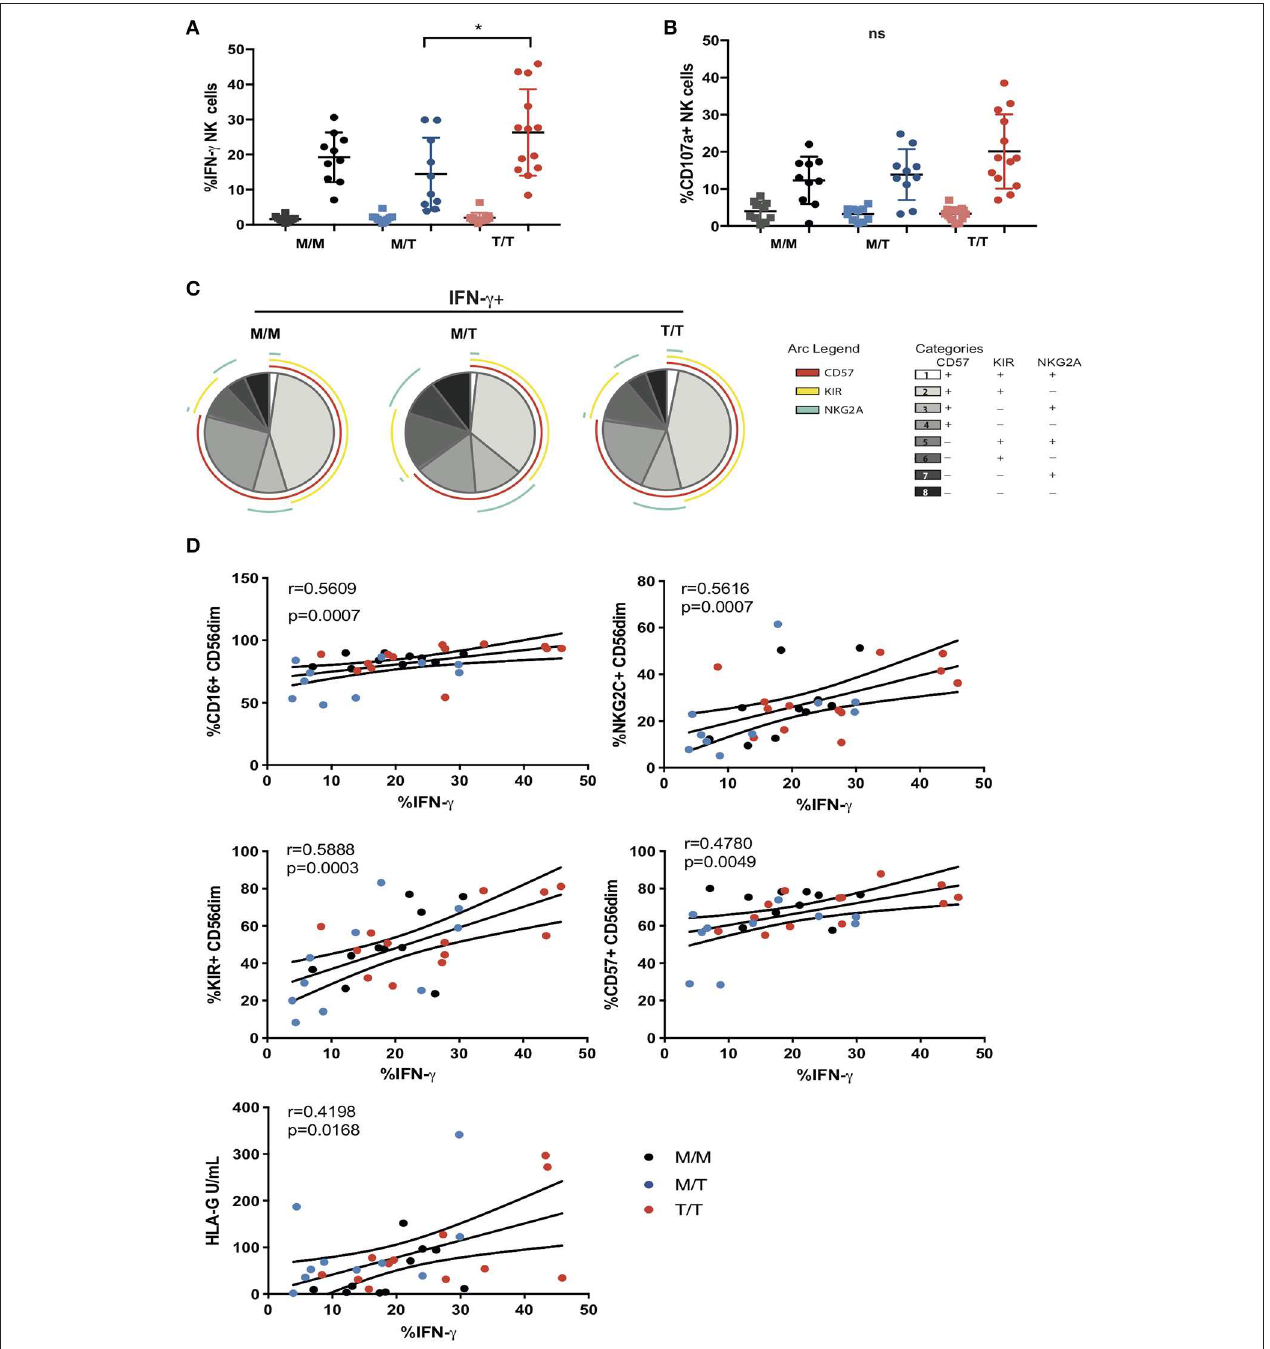
FIGURE 4 | Variable influence of -21 HLA-B dimorphism on ADCC responses. (A) IFN- γ and (B) CD107a expression by CD56 dim NK cells following co-culture with RAJI cells coated with anti-CD20 (filled circles) or murine IgG (filled squares) in M/M ( n = 10), M/T ( n = 10) and T/T donors ( n = 13) with available PBMC. (C) SPICE pie charts for each group. The pie slices correspond to the proportion of IFN- γ producing cells that express different receptor combinations, and the pie arcs depict individual expression of CD57, KIRs, and NKG2A, as detailed in the key. (D) Correlations between IFN- γ production by CD56 dim NK cells and expression of CD16, CD57, KIRs, NKG2C, or soluble HLA-G levels. The non-parametric Spearman test was used for correlation analysis.